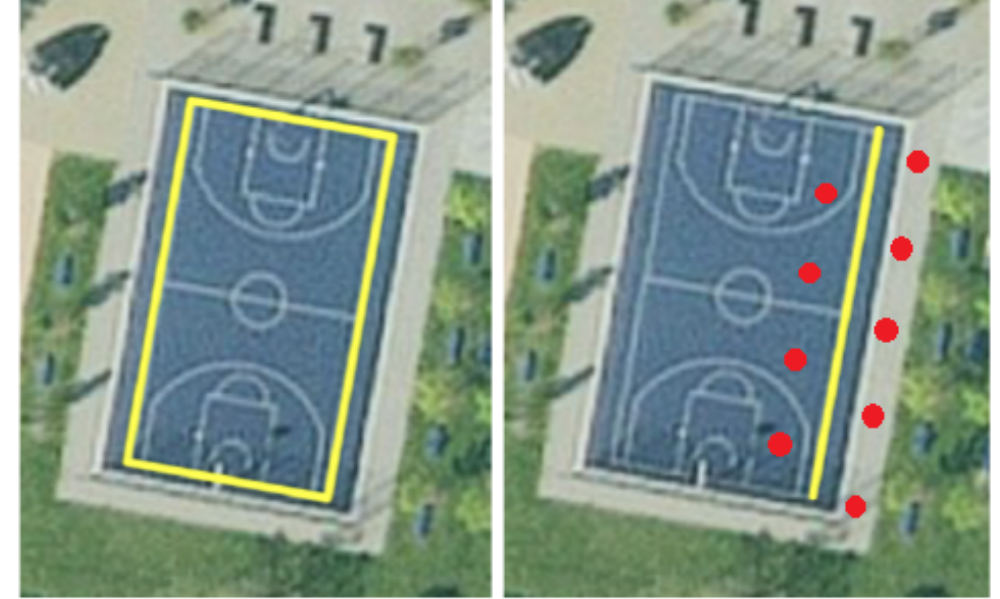
Figure 13. Ground truth/path of Dataset 1 ( left ) and Dataset 2 ( right